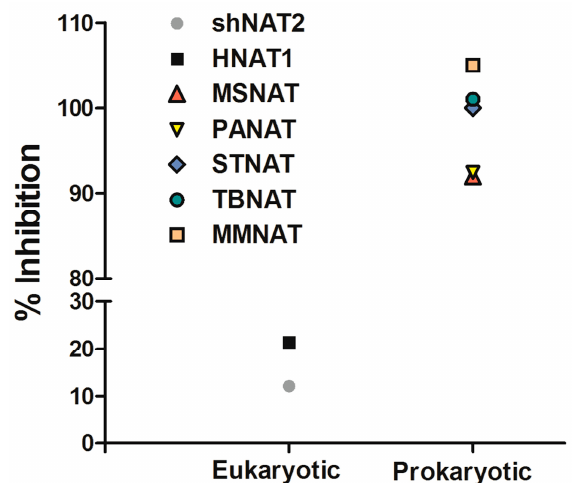
Figure 1. Specificity of 1 for prokaryotic N -acetyltransferase (NAT)